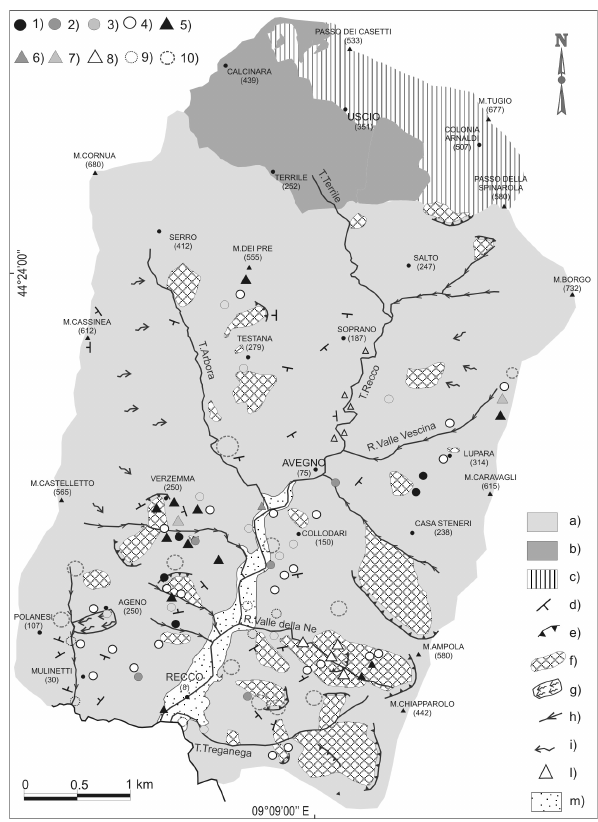
Fig. 2. Geomorphological sketch map of Recco Stream